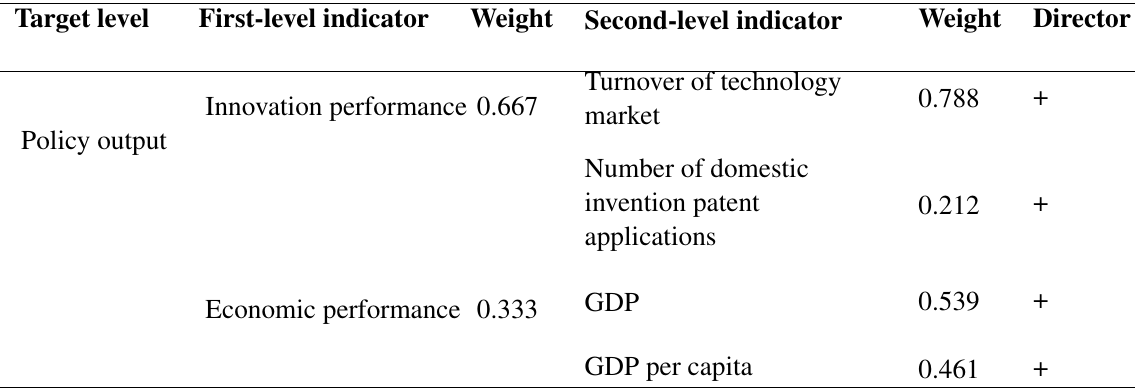
Table 4 Policy Output Indicator System and Weight of Government Guidance